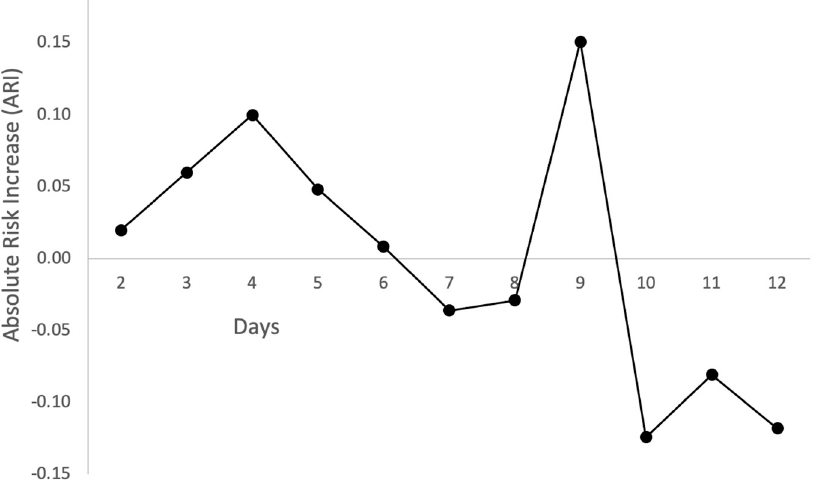
Figure 2. Distribution of absolute risk increase (ARI) over time (days between initial positive and first negative SARS-CoV-2 swab test result).